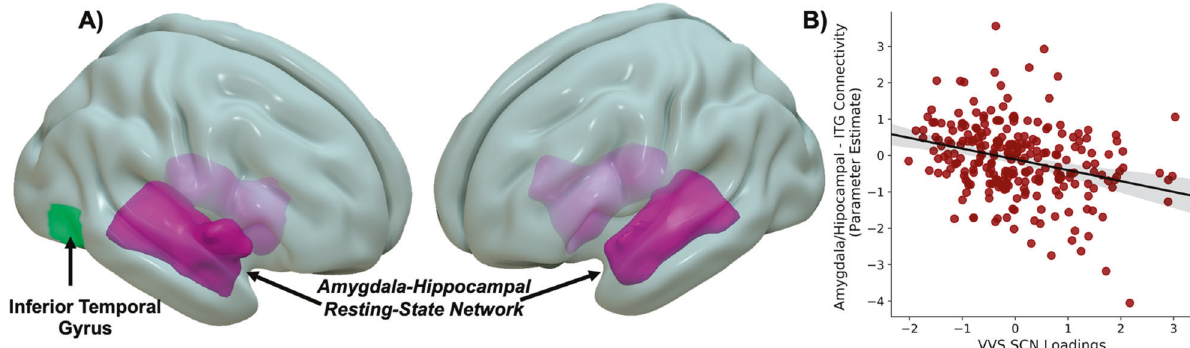
Fig. 3 Ventral visual stream structural covariance strength is associated with arousal network connectivity to inferior temporal gyrus. We observed that strength of a structural covariance network of the ventral visual stream modulated connectivity between an amygdala- hippocampal functional covariance network and inferior temporal gyrus ( A ) such that greater structural covariance network loadings were associated with negative connectivity ( B ). Scatter plots are full plots where dots represent individual participant linked independent components analysis component loadings and parameter estimates of amygdala/hippocampal to inferior temporal gyrus connectivity. Lines represent the linear line of best fi t and the shaded bar represents the 95% con fi dence